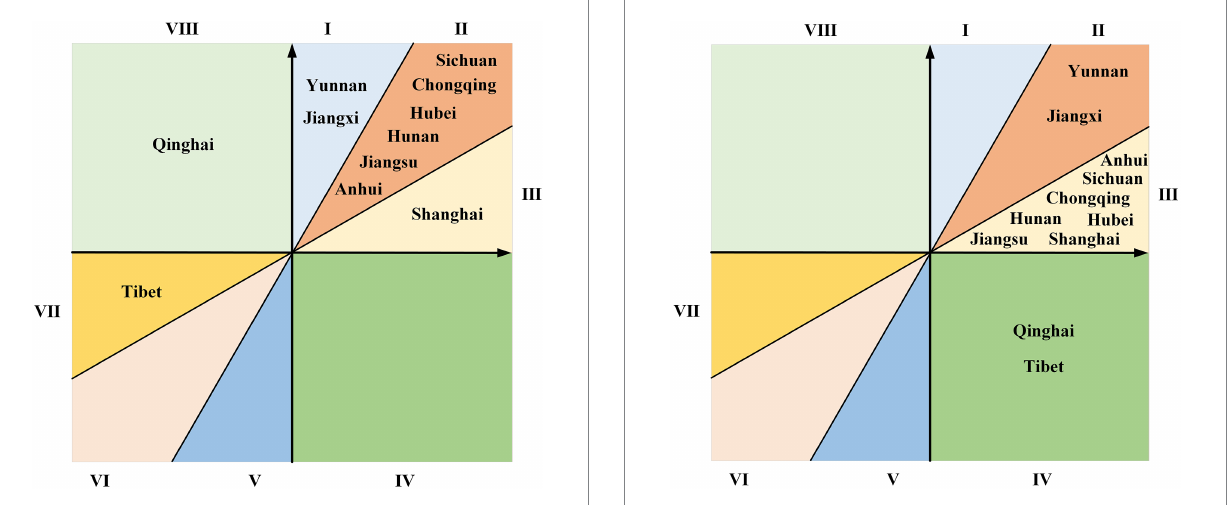
FIGURE 10 The decoupling state in different provinces from 2000 to 2009.